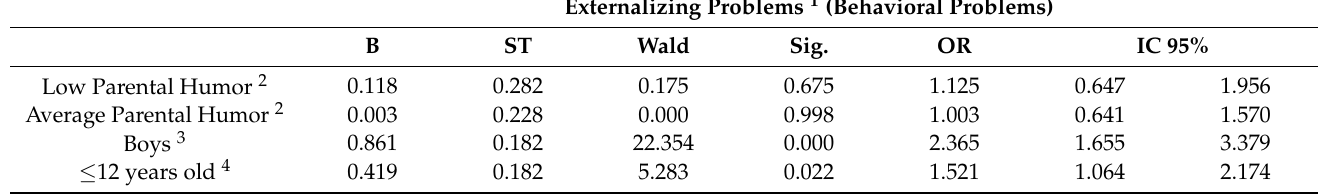
Table 3. Binomial Logistic Regression and Odds Ratio based on dependent variable Externalizing Problems and Parental